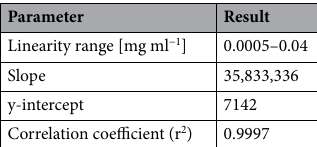
Table 2. Linearity parameters (regression analysis of calibration curves, n = 3).